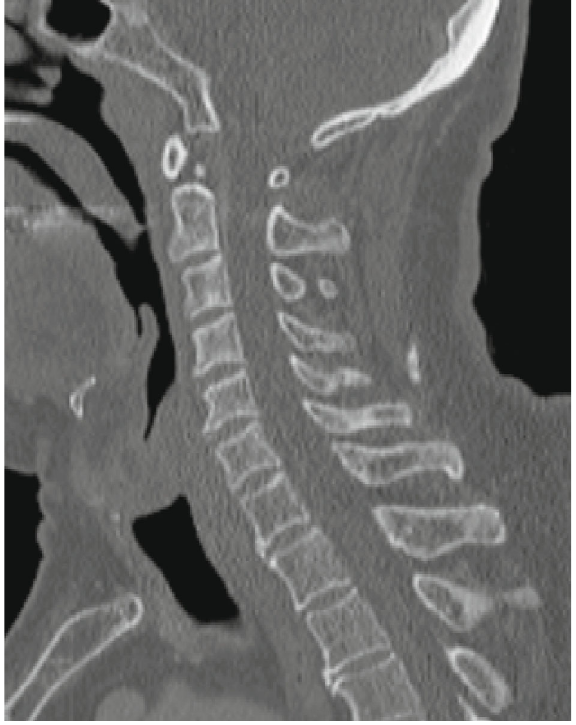
Figure 1: CT of the cervical spine showed no